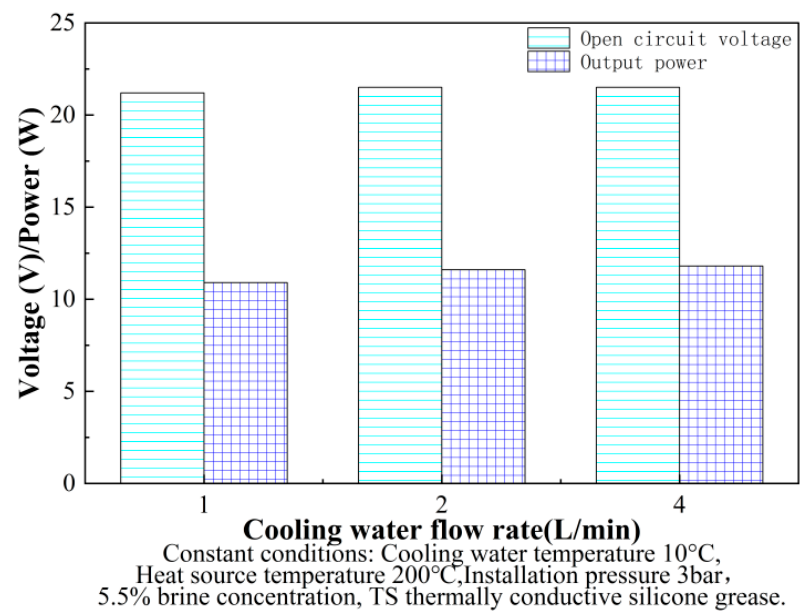
Figure 5. Effect of cooling water flow rate on open-circuit voltage and output power.